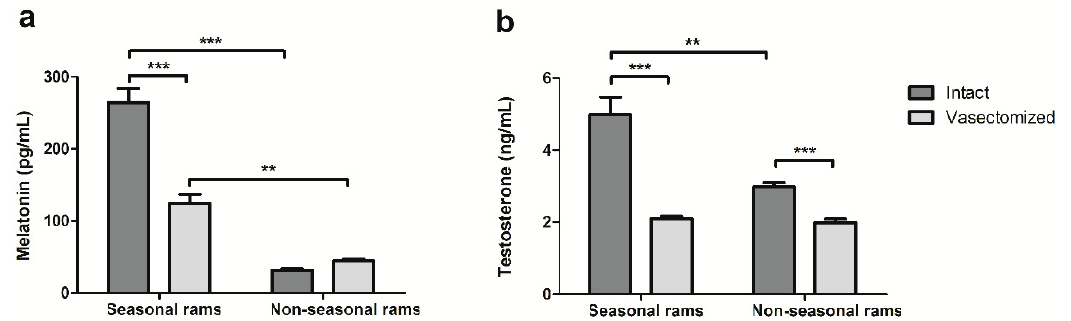
Figure 3. ( a ) Melatonin and ( b ) testosterone concentration in seminal plasma of intact and vasectomized rams subjected to temperate (seasonal rams) or equatorial (non-seasonal rams) photoperiod. Results are shown as mean ± S.E.M of n = 12 seminal plasma samples for seasonal rams, and n = 24 seminal plasma samples for non-seasonal. ** p < 0.01, *** p <